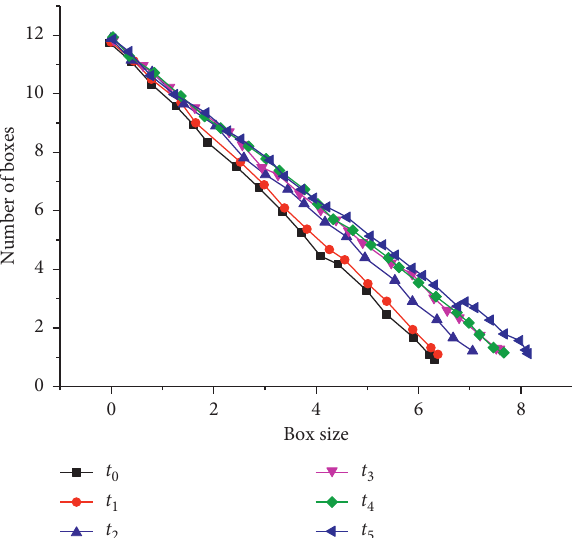
Figure 9: The fractal dimension analysis results of the binary brain function network corresponding to different time stages. 0.00.51.01.52.02.5 0.30.2